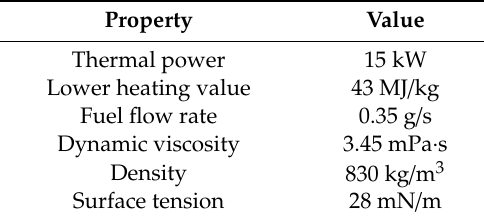
Table 2. Fuel properties at 25 ◦